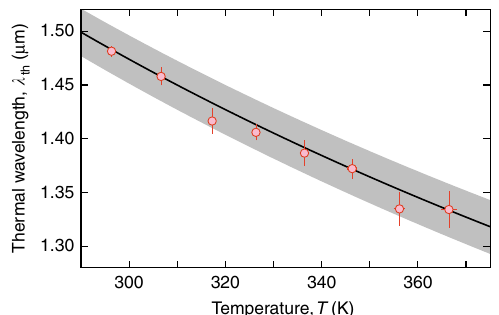
Fig. 3 Temperature dependence of the thermal de Broglie wavelength. Variation of the determined thermal de Broglie wavelength of the two-dimensional photon gas with the temperature of the dye microcavity apparatus. The data are in good agreement with the theory curve ffiffiffiffiffiffiffiffiffiffiffiffiffiffiffiffiffiffiffiffi p λ ¼ h = 2 π m eff k B T ( solid line ), expected for a particle with mass th m eff = ħ ω cutoff / c 2 at temperature T . The shaded area indicates the systematic uncertainty due to the correction for the measured fi nite imaging system resolution. The statistical uncertainty (s.d.) is indicated by the error